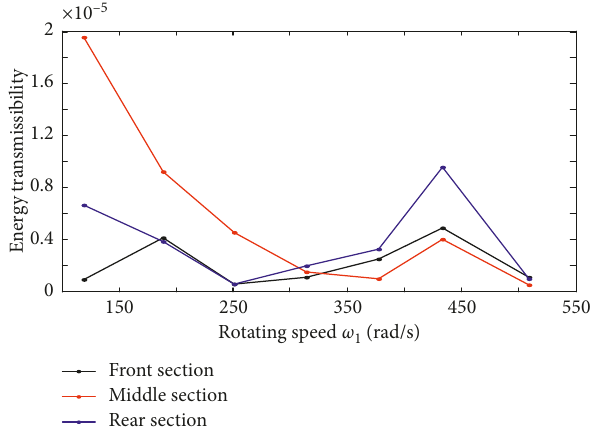
Figure 22: Experimental energy transmissibility η with varying rotating speed of low-pressure rotor ω l : front section (black), middle section (red), and rear section (blue).